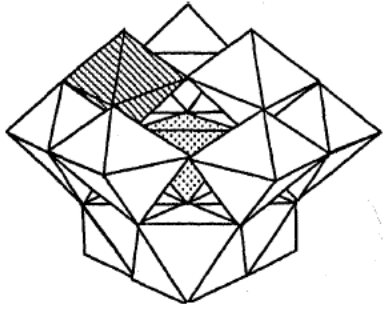
Figure 3. Polyhedral representation of monosubstituted Keggin-type POM O ] (8-n)- where the central tetrahedron represents the XO [X n+ VW 11 40 unit, the shaded octahedron represents the VO the WO 6